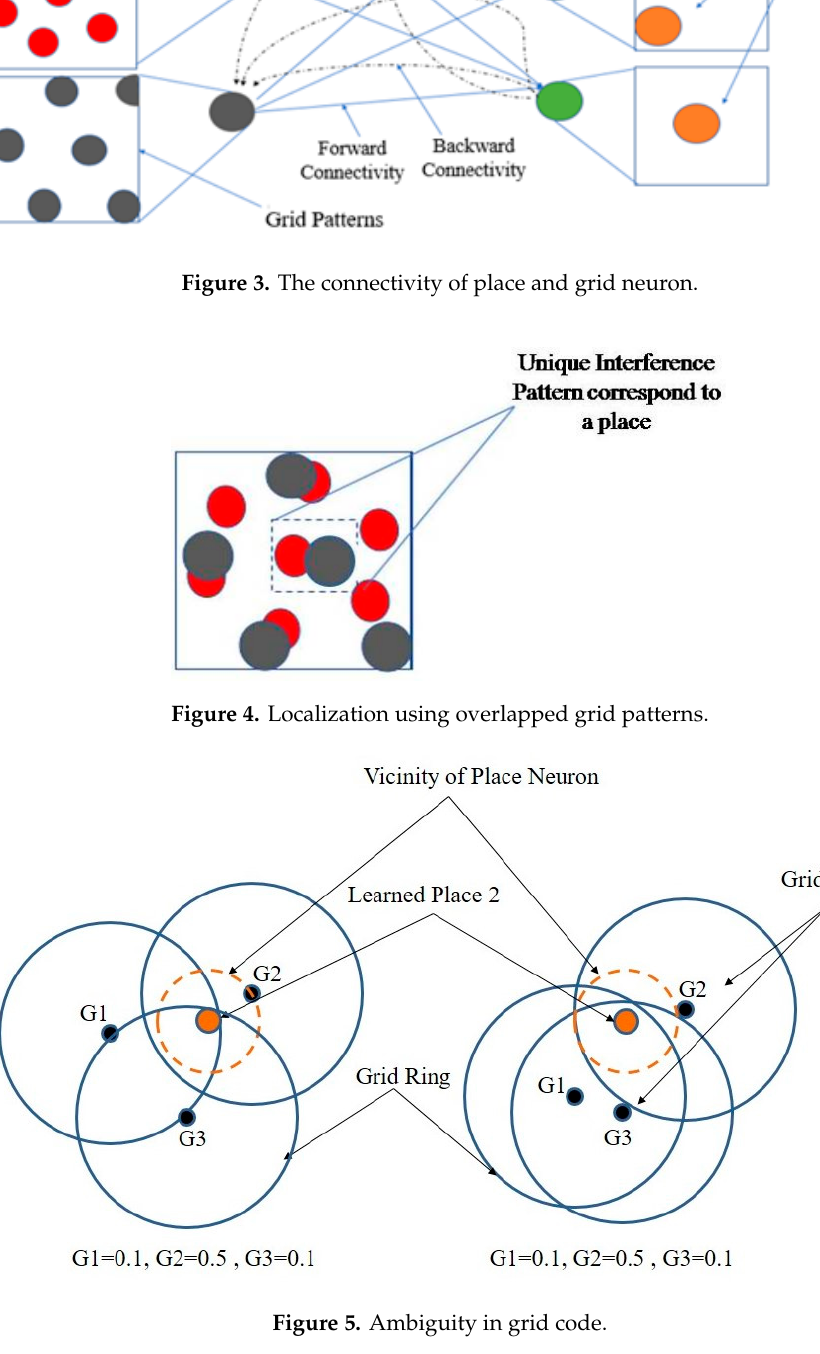
Figure 3. The connectivity of place and grid neuron.